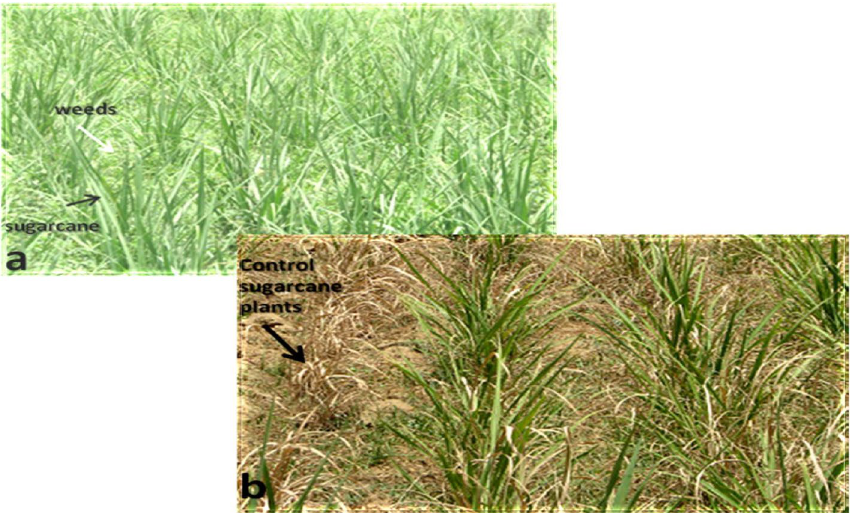
Figure 12. Glyphosate herbicide spray assay (1200 ml/acre) of sugarcane transgenic plants and Weed/non- transgenic (V 0 -genearation). ( a ) Transgenic sugarcane field plants before spray. ( b ) Non-transgenic plant and weeds died after glyphosate spray (1200 ml/80 L/acre), while survived transgenic sugarcane plants in the field after 5–7 days of spray.